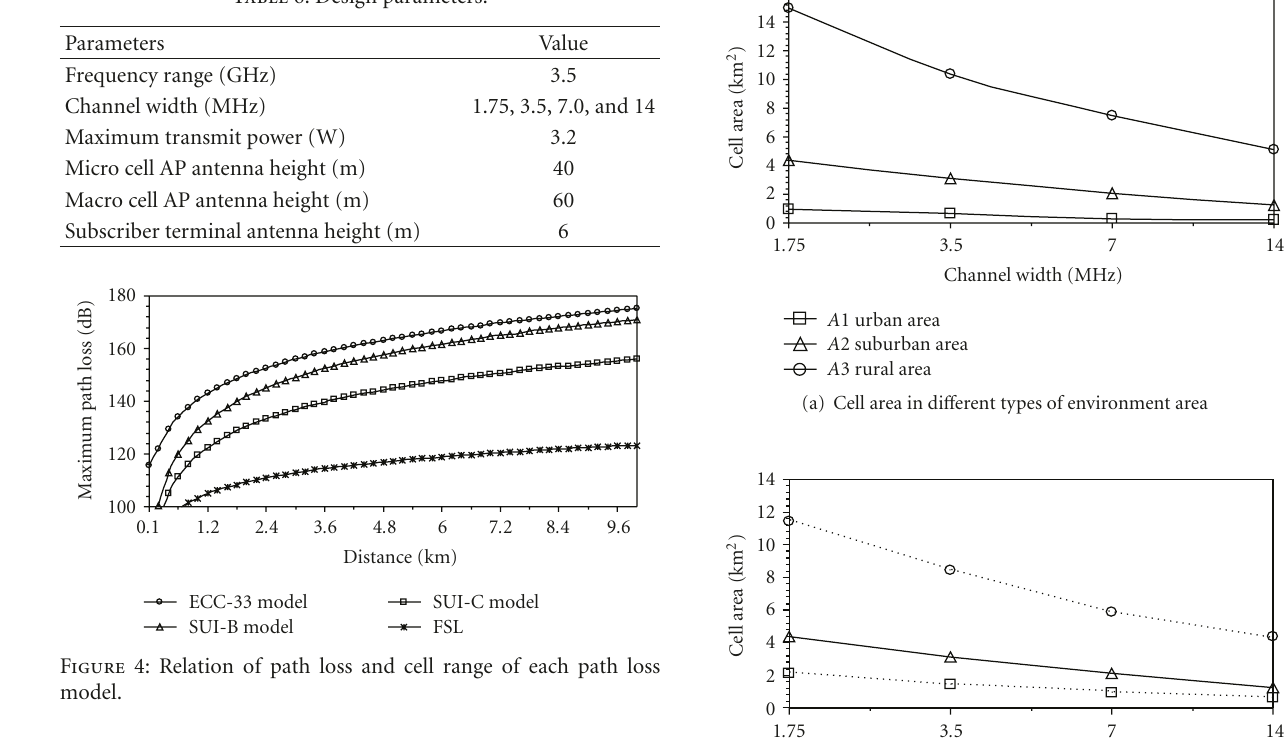
Table 6: Design parameters.